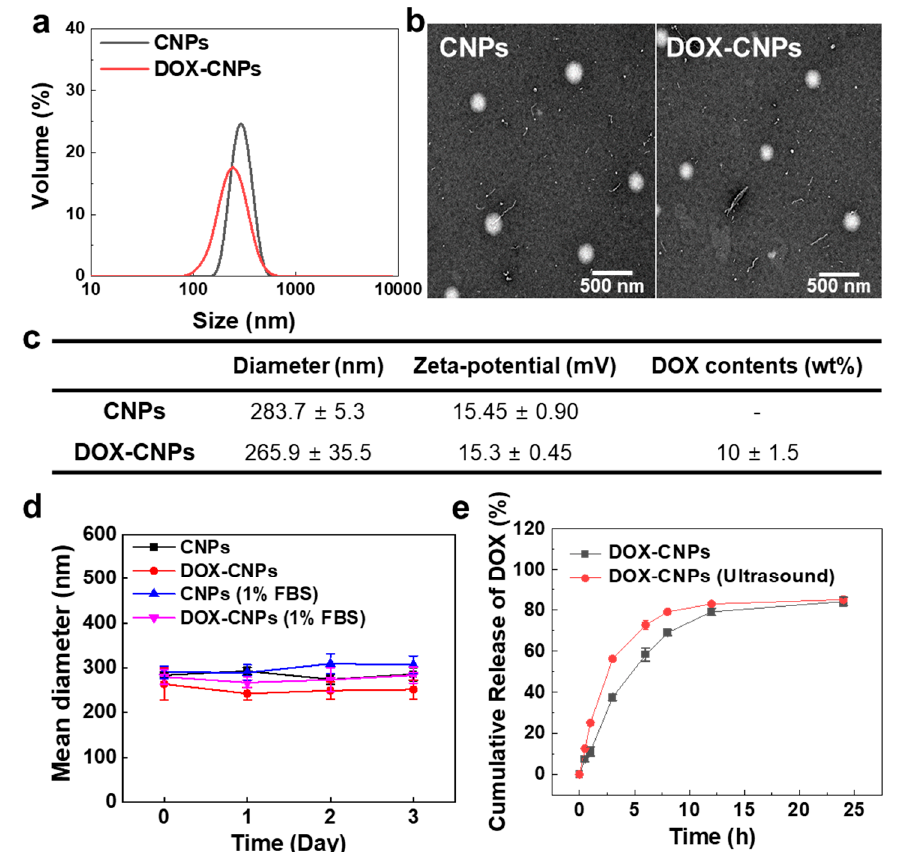
Figure 2. Physicochemical properties of DOX-CNPs in vitro. ( a ) The volume-weighted size distribution of CNPs and DOX-CNPs (1 mg / mL) in PBS (pH 7.4), measured using dynamic light scattering. ( b ) TEM image of CNPs and DOX-CNPs. ( c ) Characteristic table of CNPs and DOX-CNPs summarized diameter, zeta potential, and DOX contents. ( d ) Size stability of CNPs and DOX-CNPs in PBS (pH 7.4) and 1% FBS-containing PBS (pH 7.4) for 3 days. ( e ) In vitro release behavior of DOX from the DOX-CNPs (mean ± SD, n = 5). HIFU treatment was carried out for 5